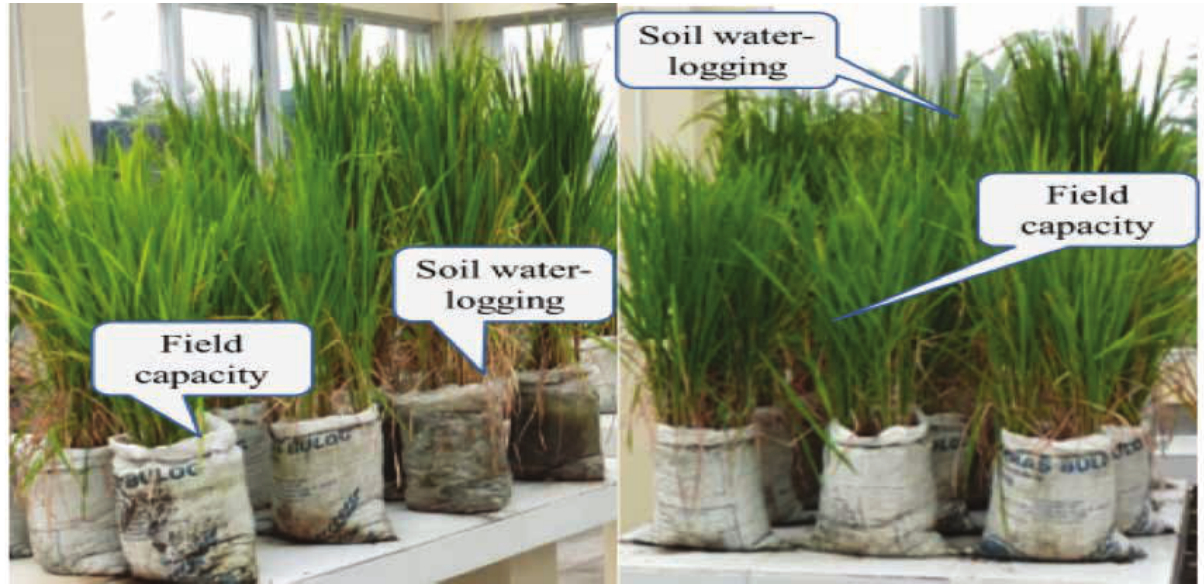
Figure 4: The Effect of Soil Water Content on the Plant Height and Greenish Leaves Performance